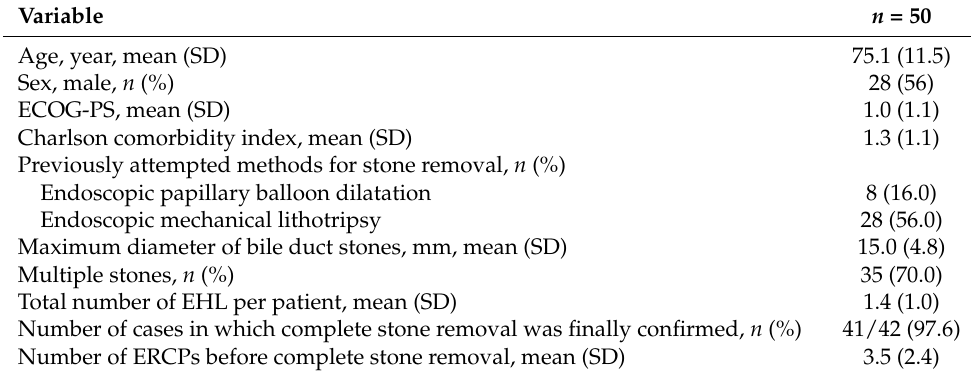
Table 1. Baseline characteristics of all eligible patients.